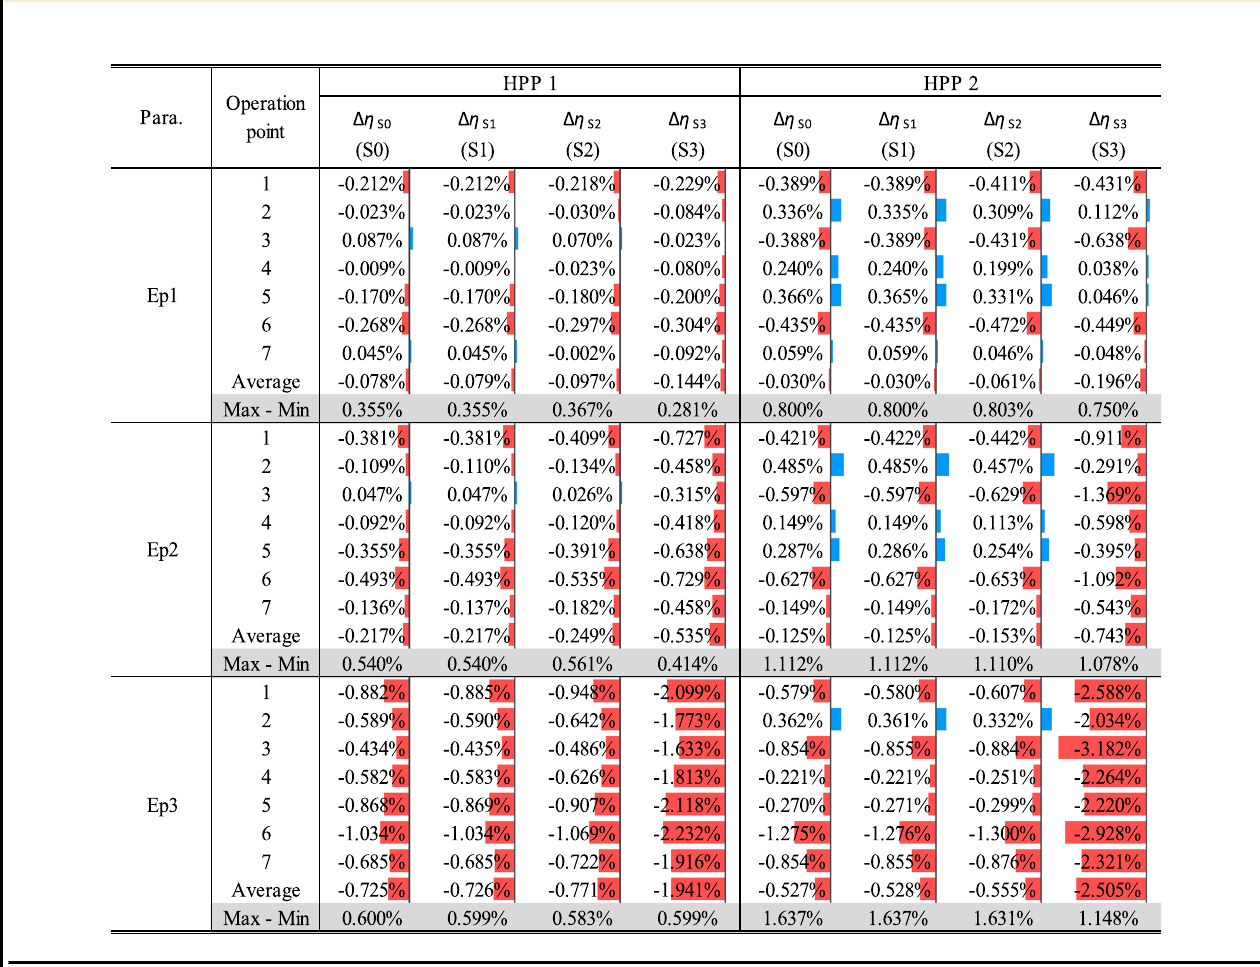
Table 2 Detailed simulation results of ef fi ciency change ( Δ η Sj )